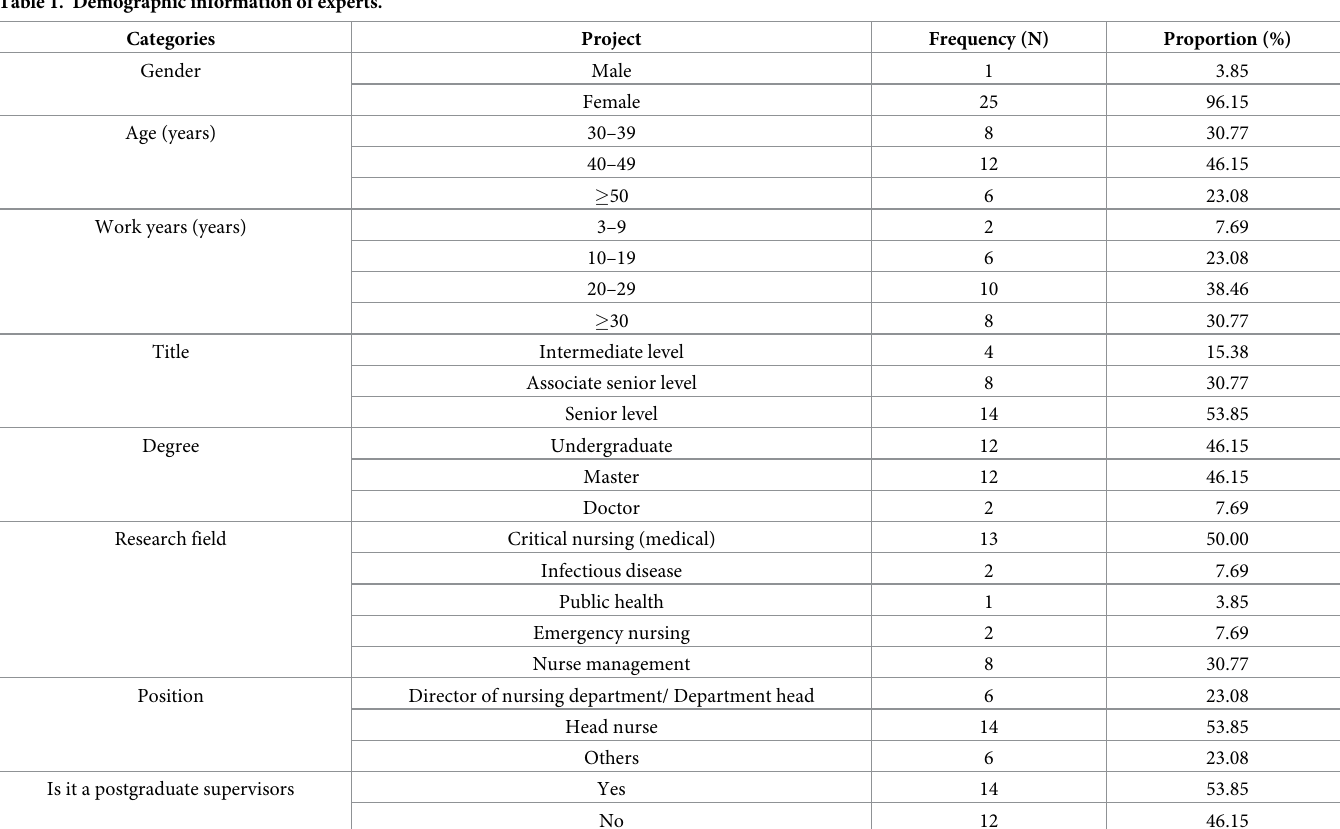
Table 1. Demographic information of experts.